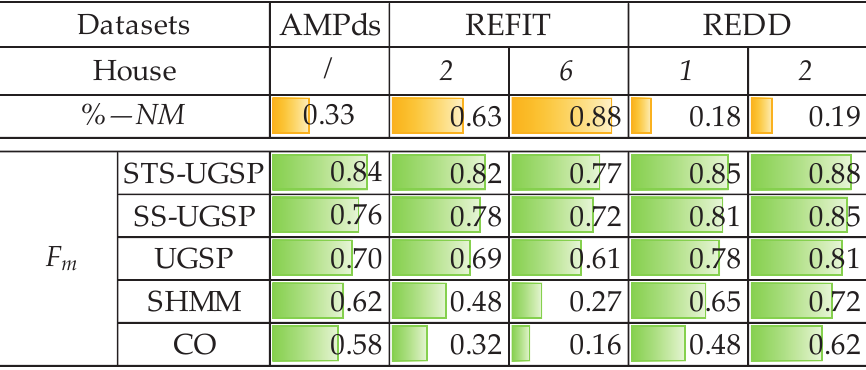
Figure 14. % − NM for various cases and their overall F m across experimental